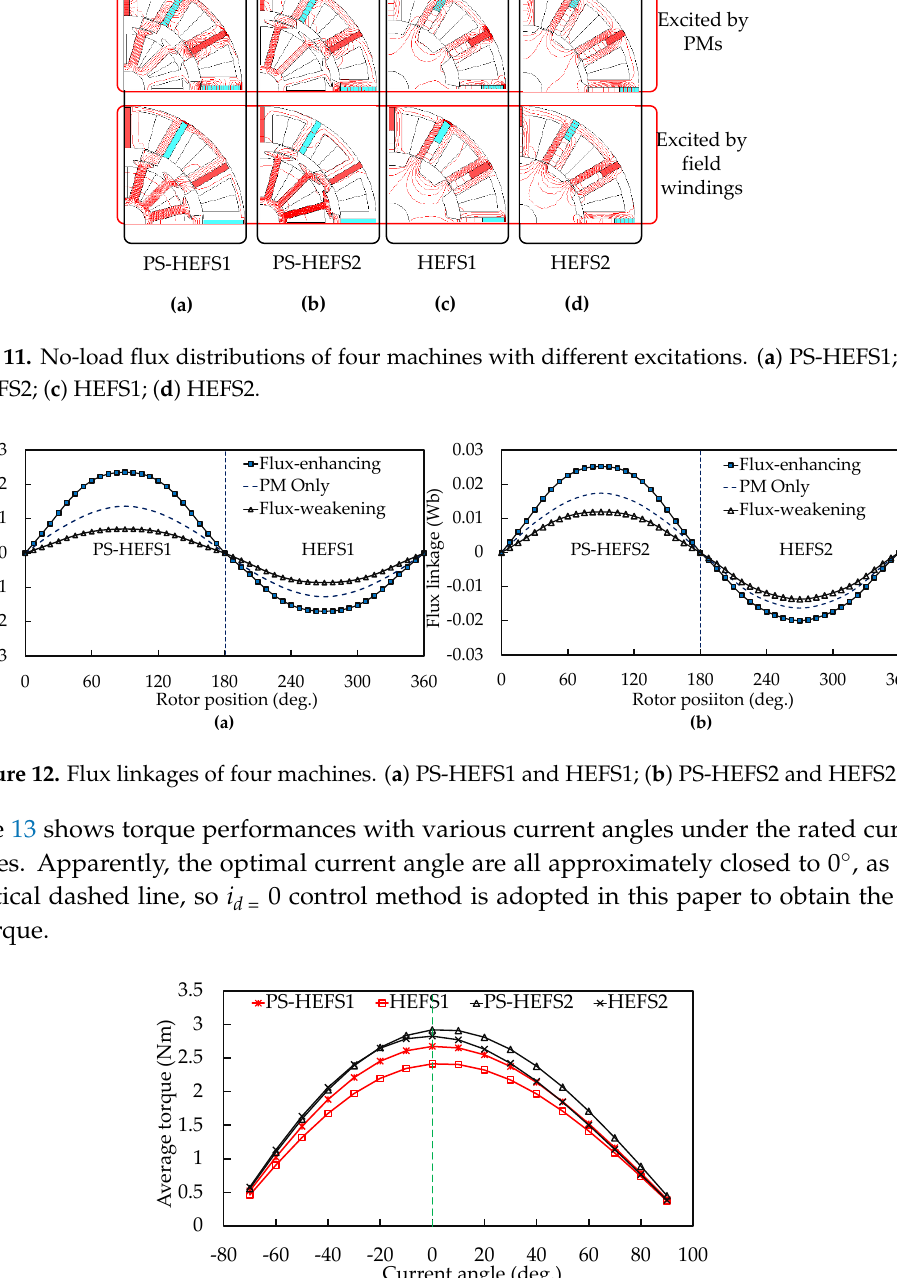
Figure 13. Variation of average torque versus current angle under with PM excitation.